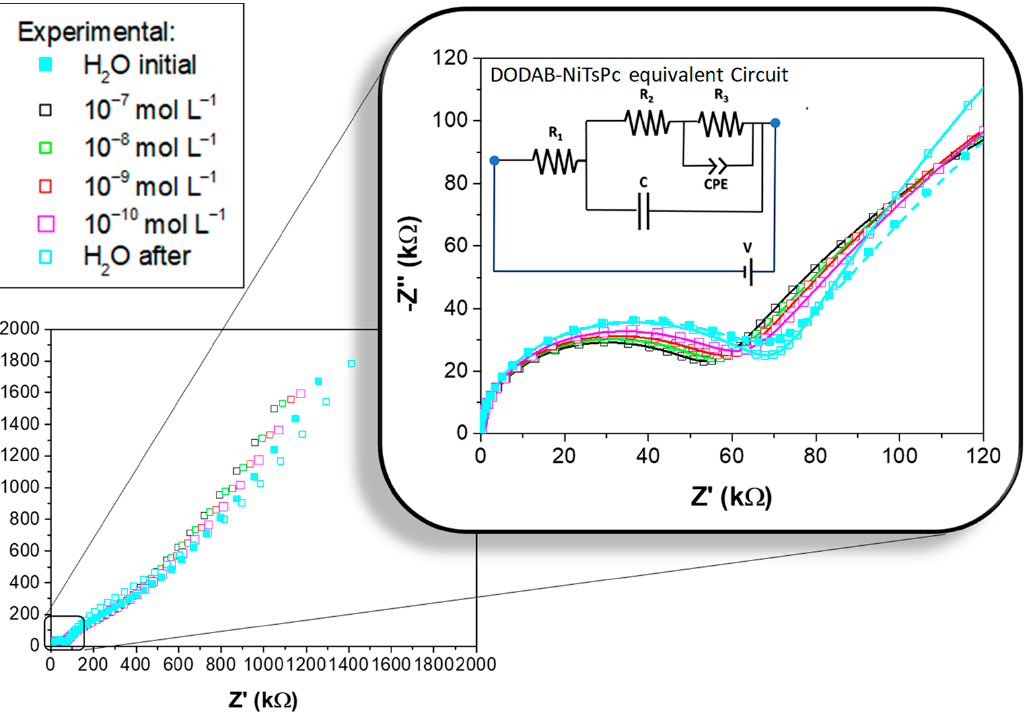
Figure 4. Cole-Cole plot (-Z”–Z’) of the (DODAB/NiTsPc) 5 sample immersed in: water initial, MBC dissolved in water at concentrations from 1.0 × 10 − 10 , to 1.0 × 10 − 7 mol L − 1 , and water final. The zoom shows the flattened semicircular region with a fitting (continuous lines) using equivalent circuit presented in the inset. IDE